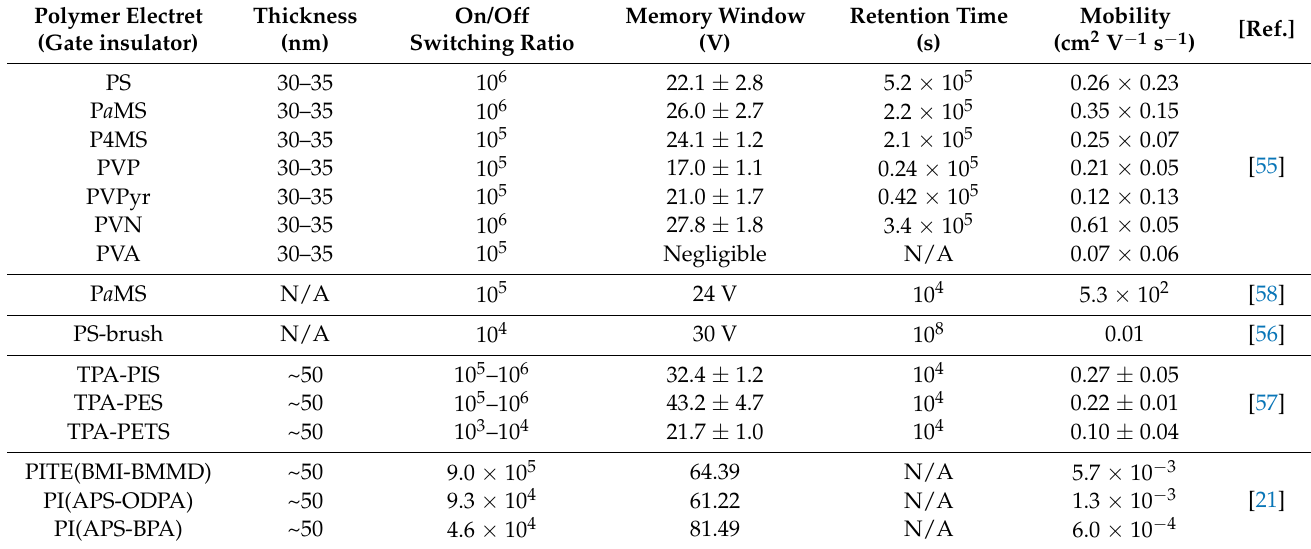
Table 2. Polymer electret memory characteristics